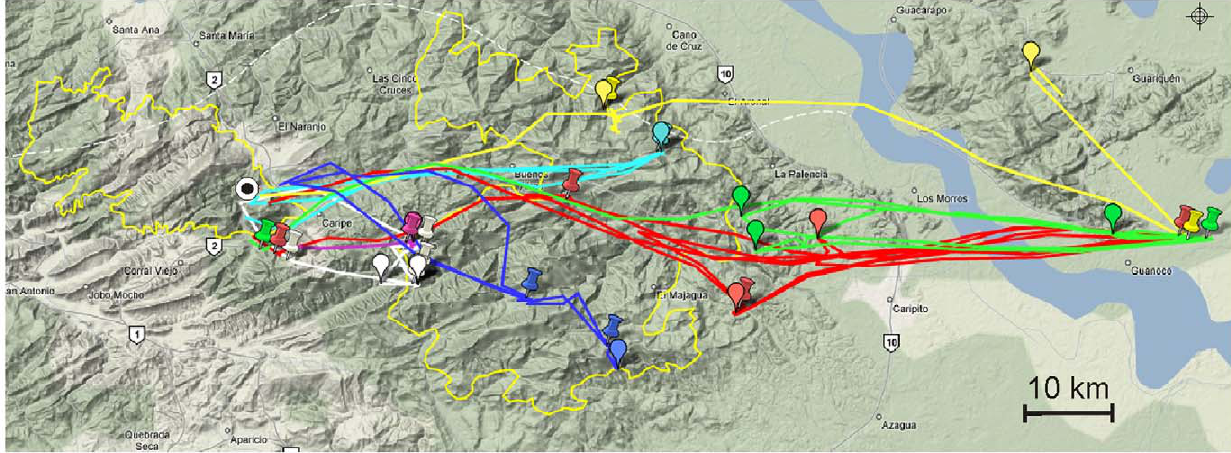
Figure 2. The tracks of all birds obtained during the study. Foraging and roosting sites used by Steatornis caripensis during the period of study, overlaid on the tracks obtained by the GPS. The drawing pin markers indicate foraging sites and the balloon markers indicate roosting sites, with the colour matching the birds track. The circular marker with the black dot is the Cueva del Gua´charo. Birds are distinguished by different coloured